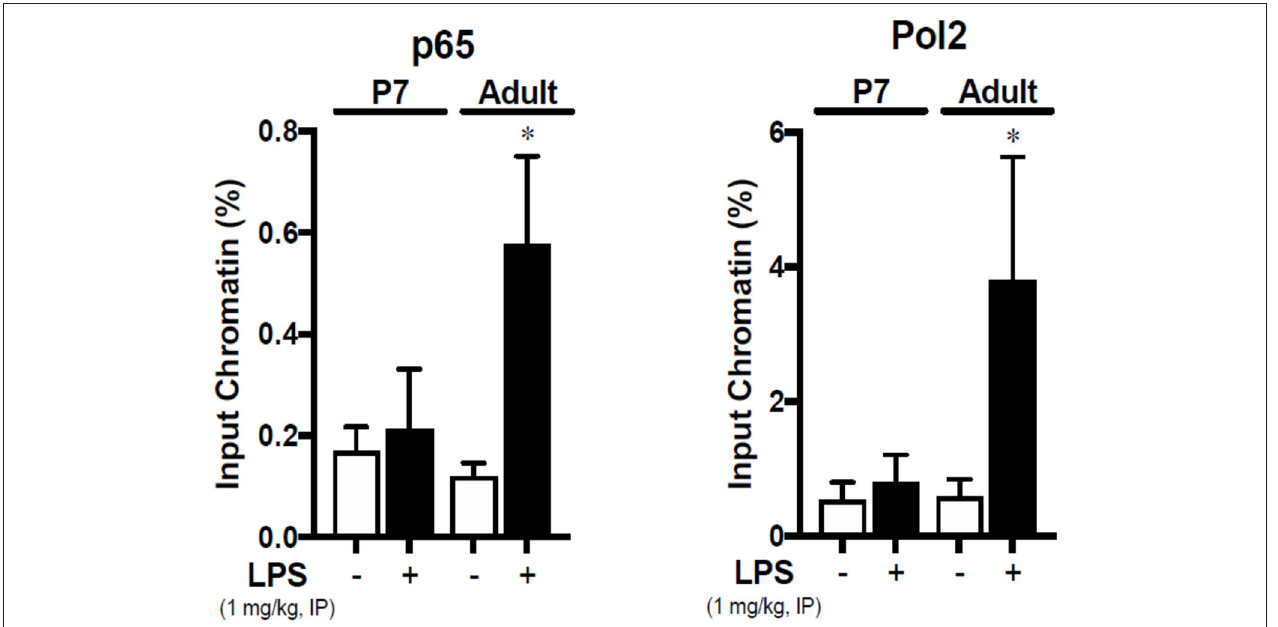
FIGURE 6 | The NF- κ B subunit p65 is bound to the Icam1 promoter in the liver of IP LPS-exposed adult mice. Adult and p7 mice were exposed to IP LPS (5 mg/Kg, 1h), and whole liver homogenates were subjected to chromatin immunoprecipitation with anti-p65 (SC-372, Santa Cruz Biotechnology, Dallas, TX, USA) and analyzed by RT-qPCR targeting the Icam1 promoter. RNA Polymerase 2 (Pol2) was used to validate the assay. * P < 0.05 vs. control (0h) by Student’s T -test. Values are represented as input chromatin percentage of RT-qPCR for the amplification of the Icam1 promoter run in